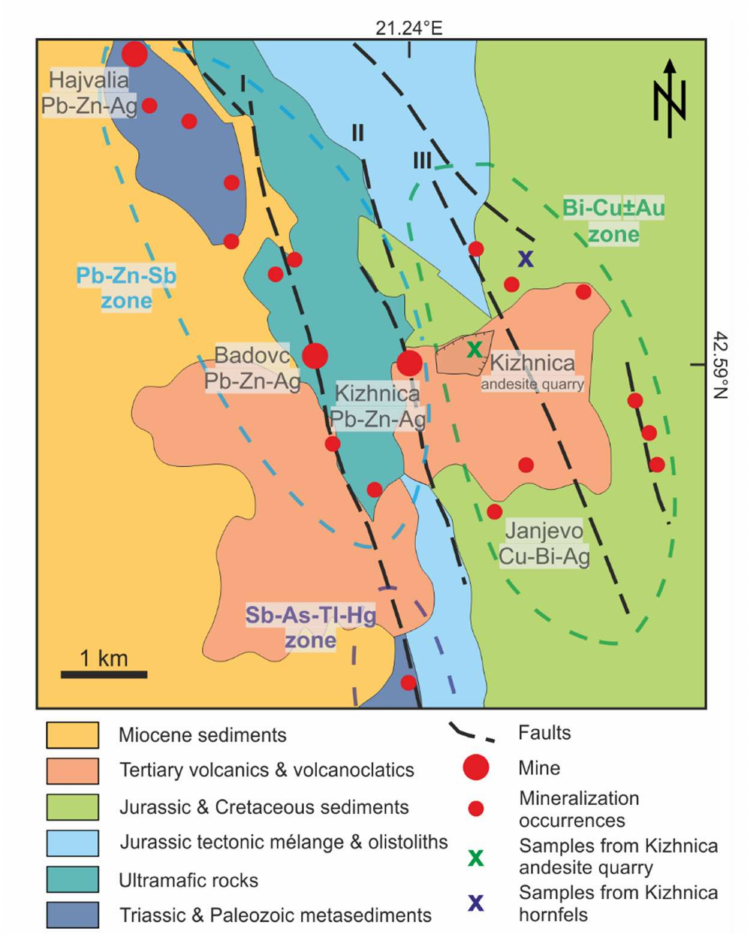
Figure 2. Simplified geological map of the Hajvalia- Kizhnica- Badovc ore field. Abbreviations: I = The Hajvalia-Badovc Tectonic Zone; II = The Kizhnica Tectonic Zone; III = The Okosnica Tec- tonic